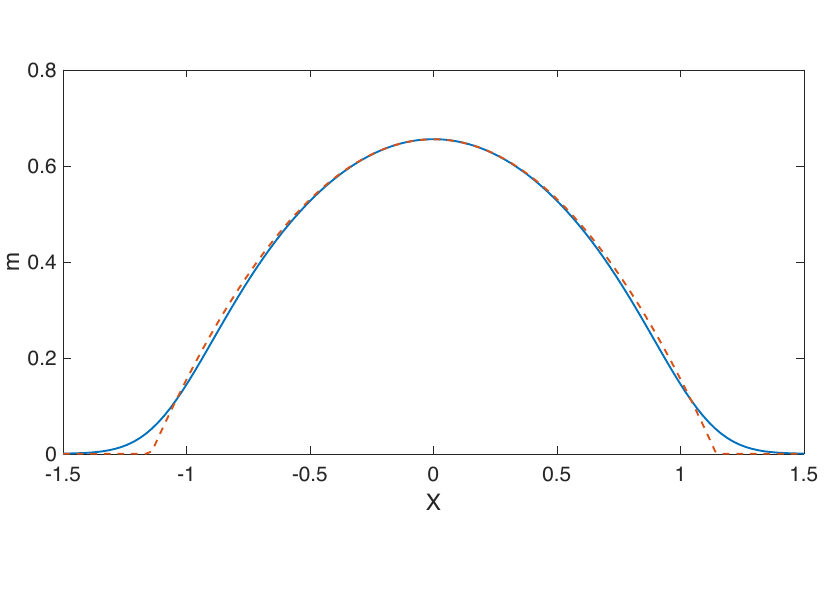
Figure 1: Computational solution of the Gross-Pitaevskii equation (full line) and Thomas-Fermi approximation (dashed line). In this case g = − 2, σ = 0.4, µ = 1 and ( x ) = − x 2 ( d = U 0